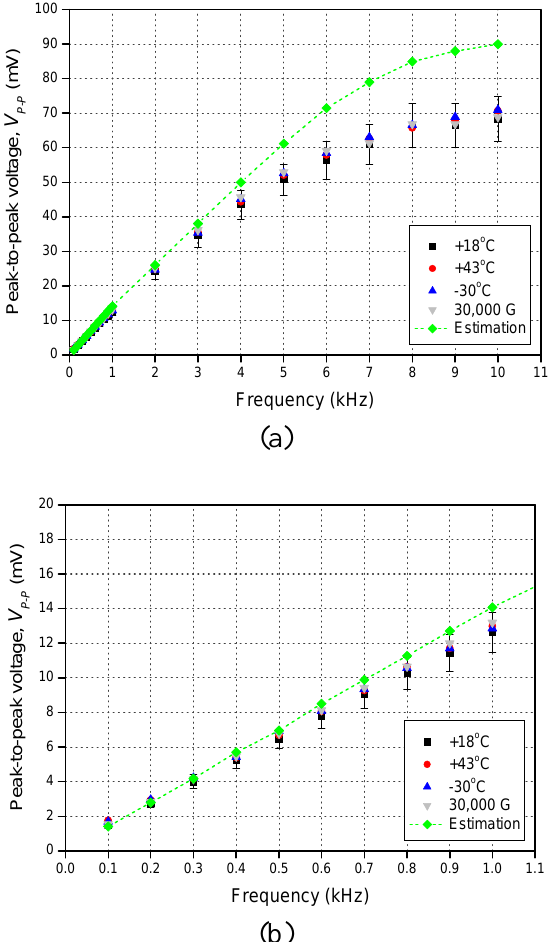
Figure 14. Measured and estimated output signals as function of rotational velocity in frequency bands of: (a) 0~10 kHz; (b) 0~1